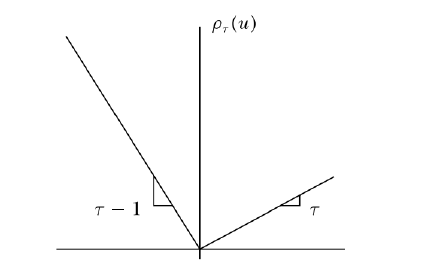
Figure 1. Quantile regression ρ